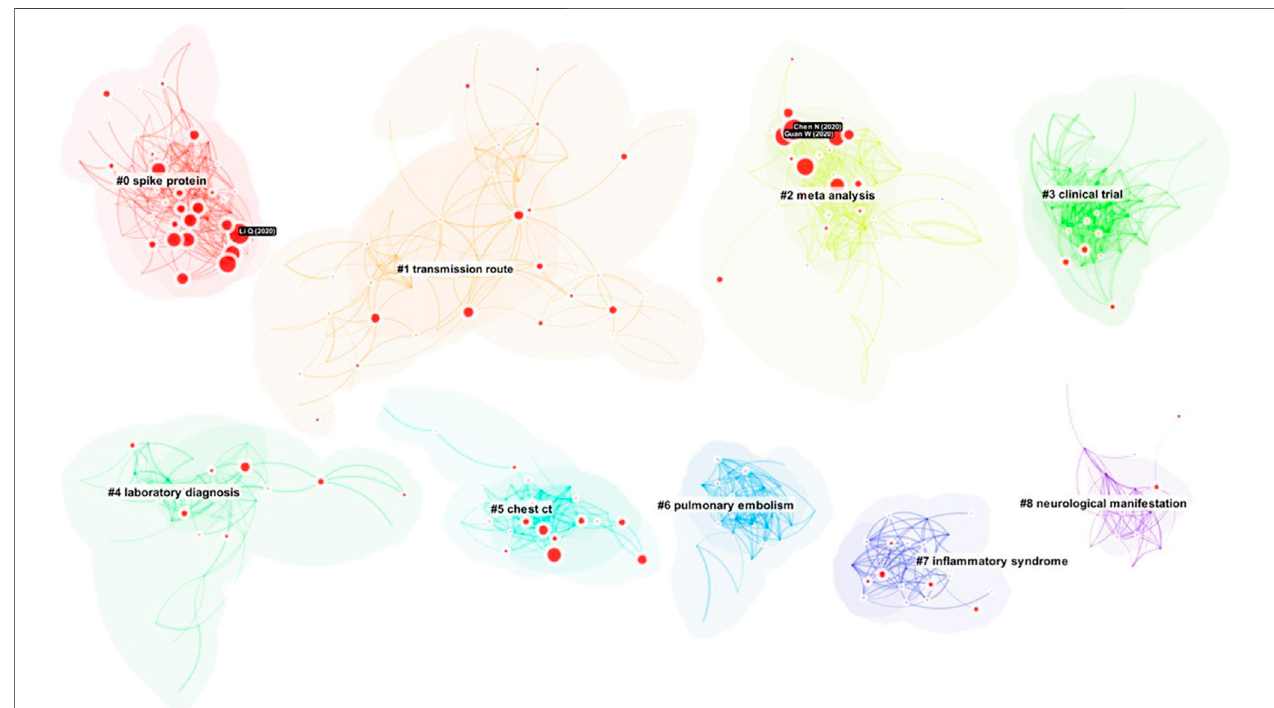
FIGURE 7 | The distribution of citation contexts with uncertainties is uneven. The most uncertainties are in clusters 0, 2, and 5.